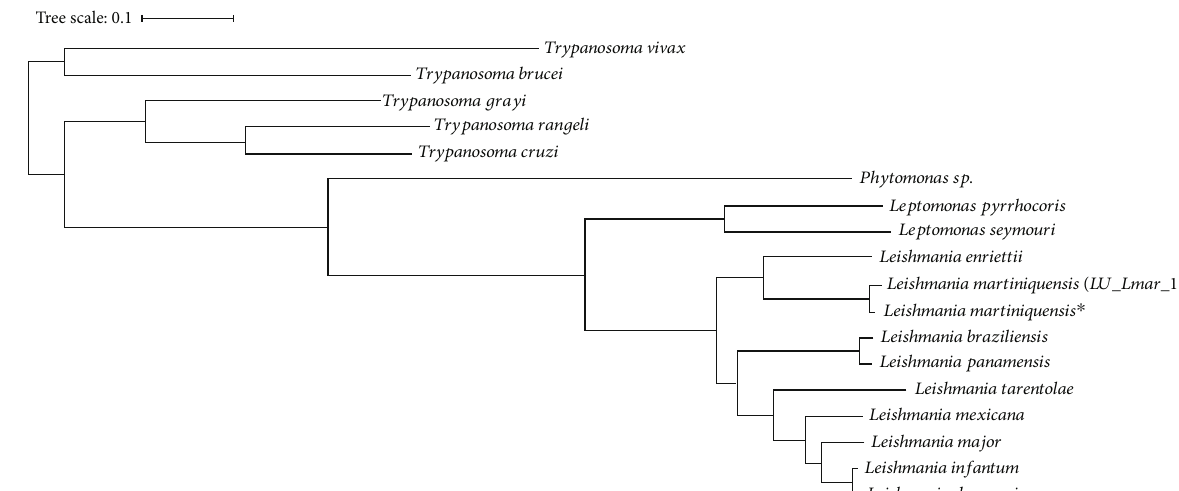
Figure 2: The phylogenetic analysis based on 17 single-copy shared orthologous genes obtained from OrthoFinder tool. The star symbol represents our Leishmania martiniquensis